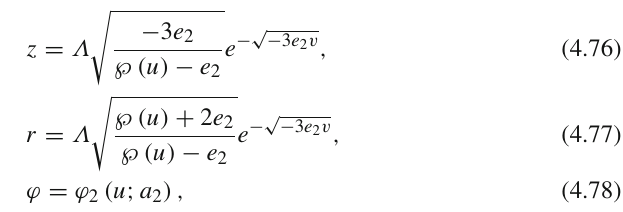
Fig. 9 The ratio of the radii of the circles comprising the entangling curveofacatenoidinPoincarécoordinates,asfunctionoftheintegration constant